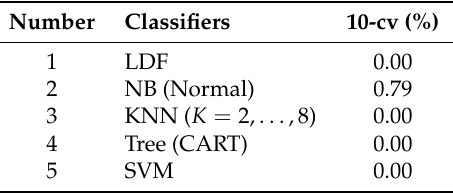
Figure 2. Macroregions in the first and second KDC systems and poviats recognized as belonging to specific macroregions. Source: own compilation. Table 3. Percentage of misclassification of poviats in the 6-dimensional space of KDC.